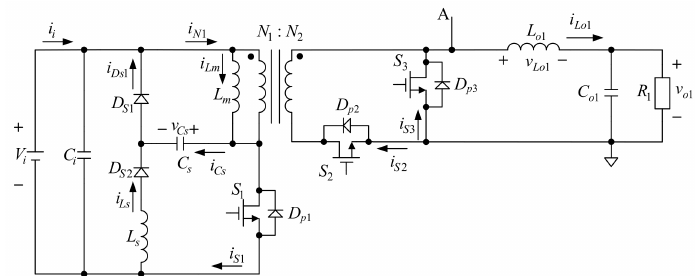
Figure 1. SR forward converter.